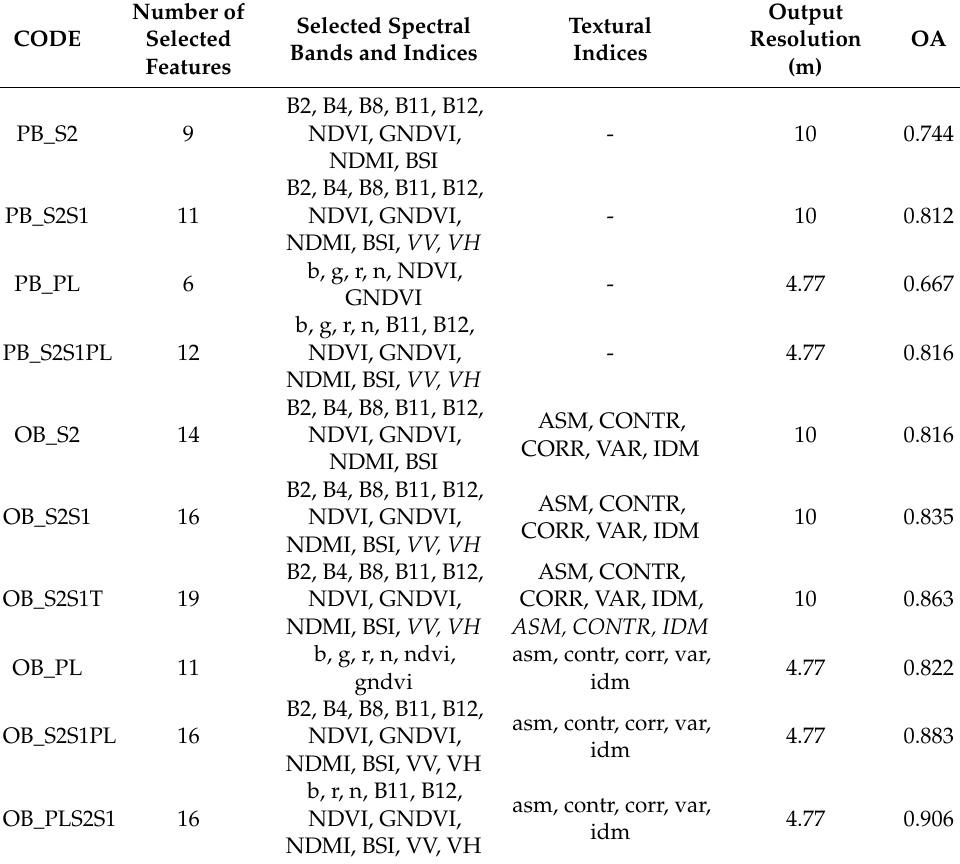
Table 5. LULC classification approaches, number of features, bands, and indices selected for the classification, output resolution, and overall accuracy (OA). Classification approaches’ codes are reported in Table 2. S2 features are in upper case, S1 features are in italic upper case, and PlanetScope features are in lower case. Spectral indices (NDVI, GNDVI, NDMI, BSI) are reported in Table 3. Textural index codes and descriptions are reported in Table 4. The statistical significance of the OA differences between the classifications is shown in Table